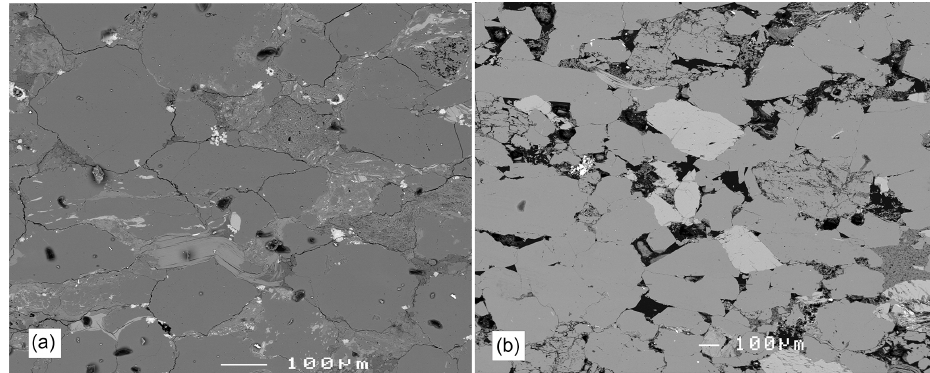
Figure 2. Back-scattered electron images showing microstructure of (a) Pennant and (b) Darley Dale sandstones. Both rocks are dominated by quartz grains (mid-grey). Clay and muscovite partially (b) or wholly (a) fill interstitial spaces. There is a weak grain shape fabric (grain long axes horizontal) in the Pennant sandstone. Porosity appears black. Bedding trace is horizontal in both cases.